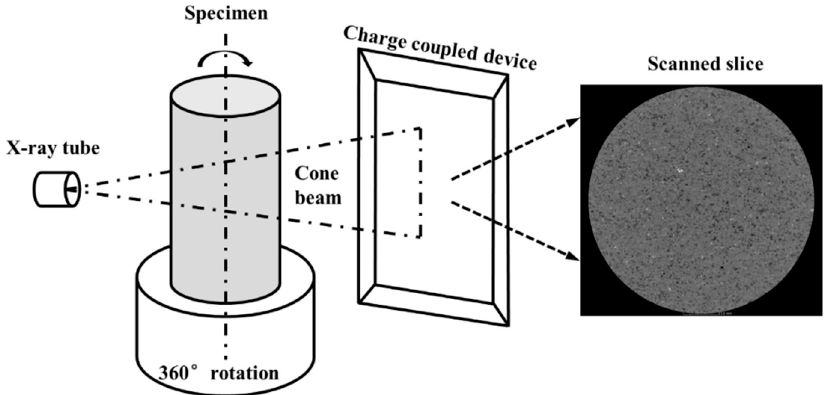
Figure 7. Schematic illustration of the CT system.